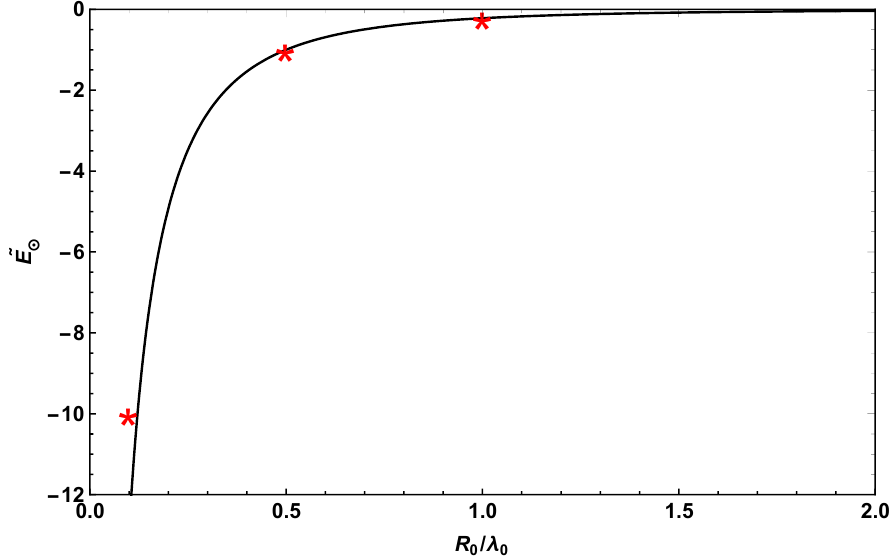
Figure 2. Binding energy ˜ E (cid:12) (taken from Equation (9) and normalized to E (cid:12) ( R 0 / λ 0 = 0.5 ) ) as the function of the ratio R 0 / λ 0 . The stars correspond to the numeric values of the binding energy taken from Oshsima’s paper [25] at points R 0 / λ 0 =